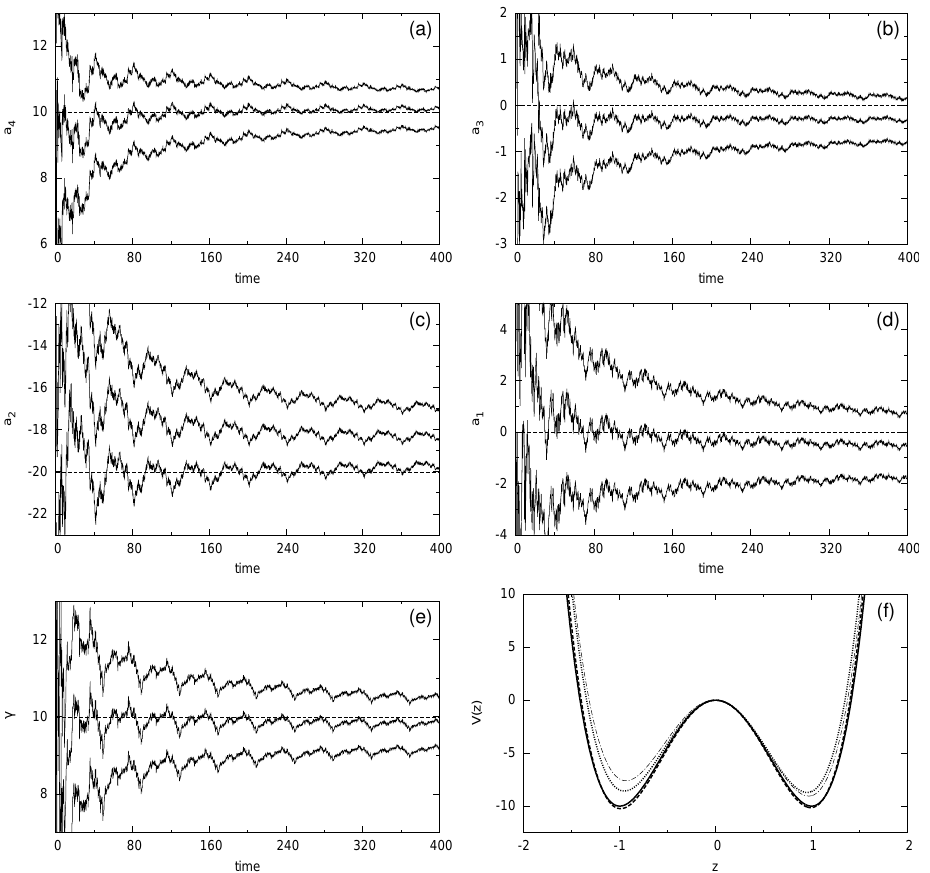
Fig. 3. Simulated data: Estimate and error standard deviation for the parameters a 4 (a) , a 3 (b) , a 2 (c) , a 1 (d) and γ (e) obtained from a particular time series of length 40 time units, processed ten times. The dashed horizontal lines indicate the true parameter values. (f) True